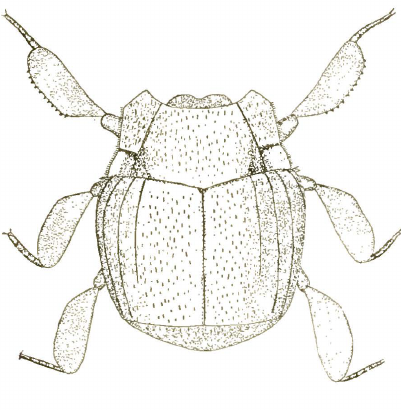
Fig. 1. H etcerius wheeleri, sp.